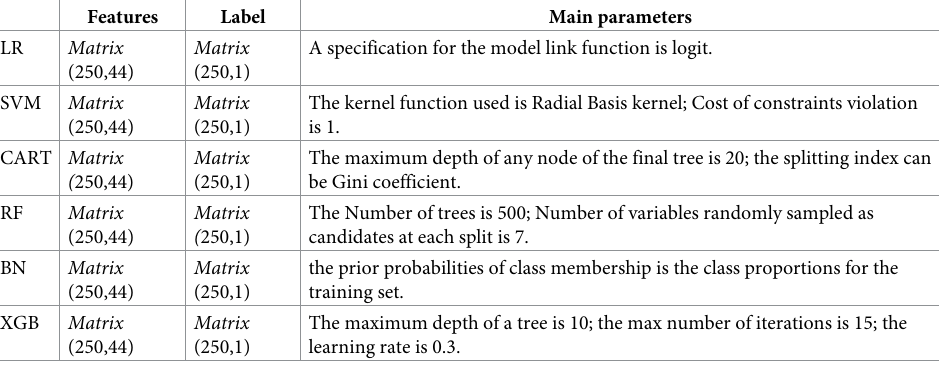
Table 1. Main parameter setting of traditional machine learning algorithms. Features